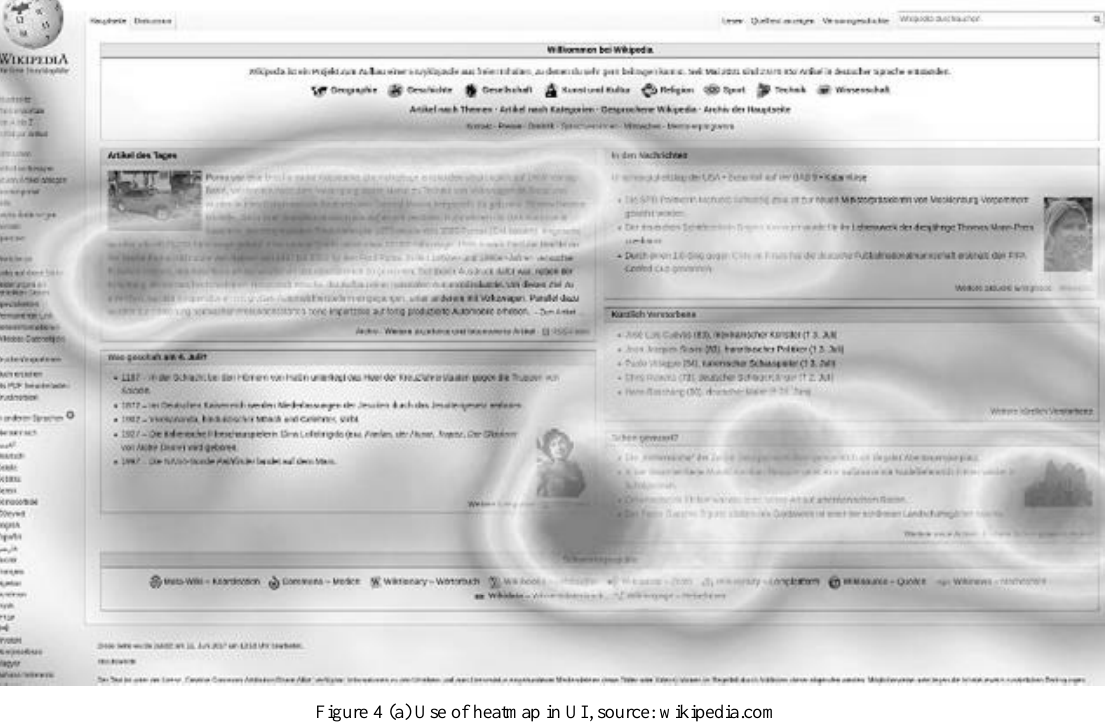
Figure 4 (a) Use of heatmap in UI, source: wikipedia.com